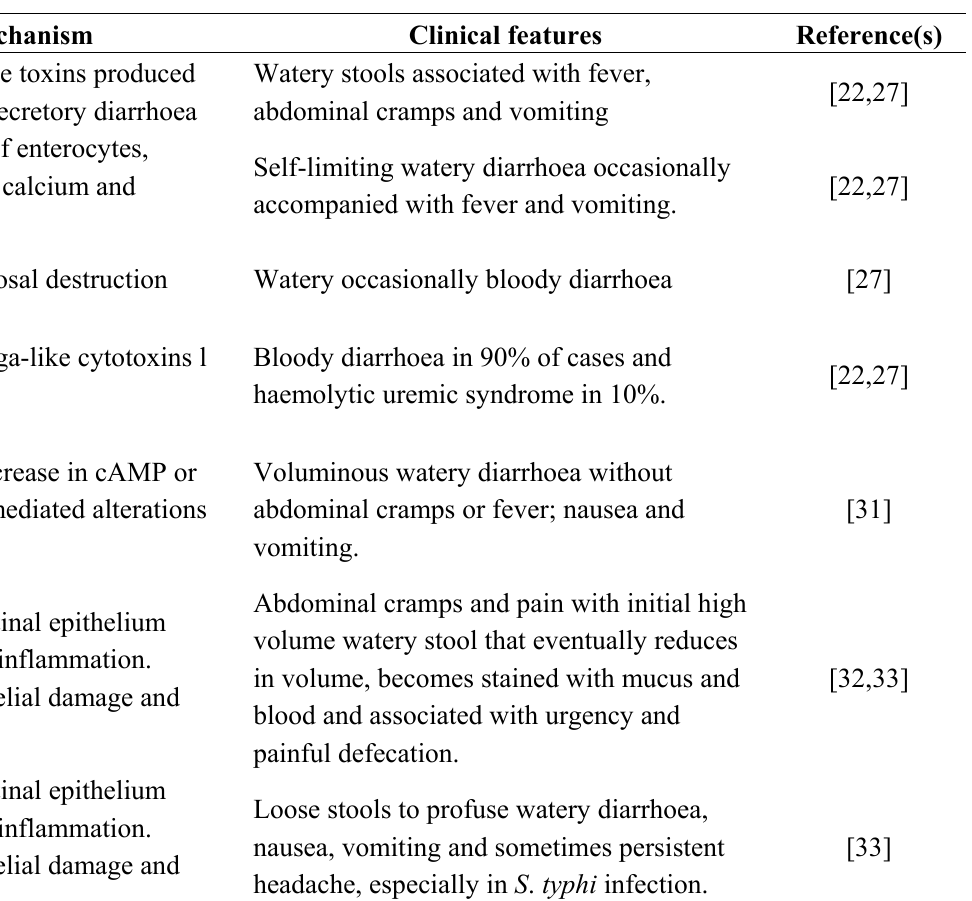
Table 1. Common forms of diarrhoea classified according to causative agent, pathogenic mechanism and clinical